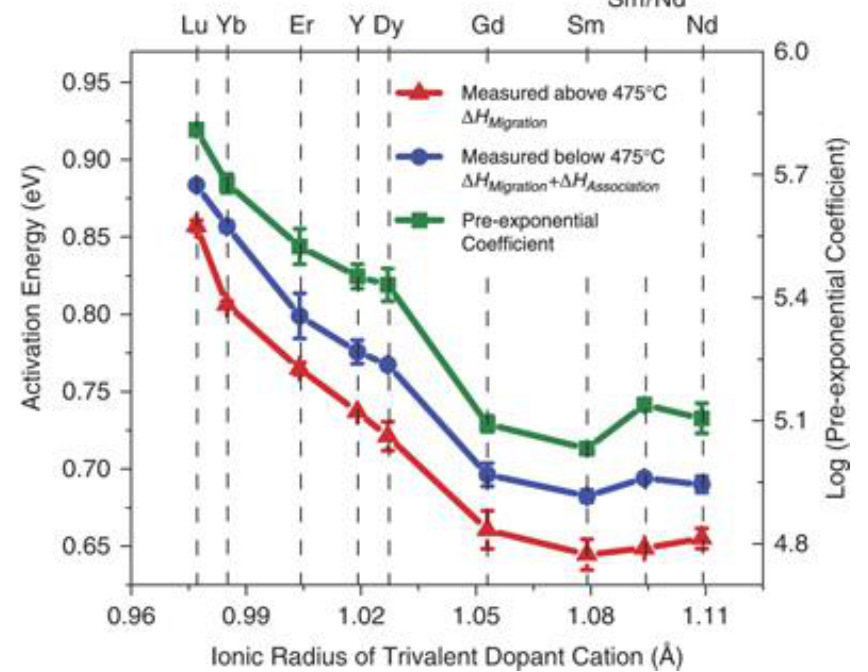
Figure 3. Behaviour of the activation energy E a below and above 750 K, and of the pre-exponential factor A as a function of the ionic size of the doping ion. Reprinted with permission from ref [34]. Copyright 2021 John Wiley and Sons License Terms and Conditions.